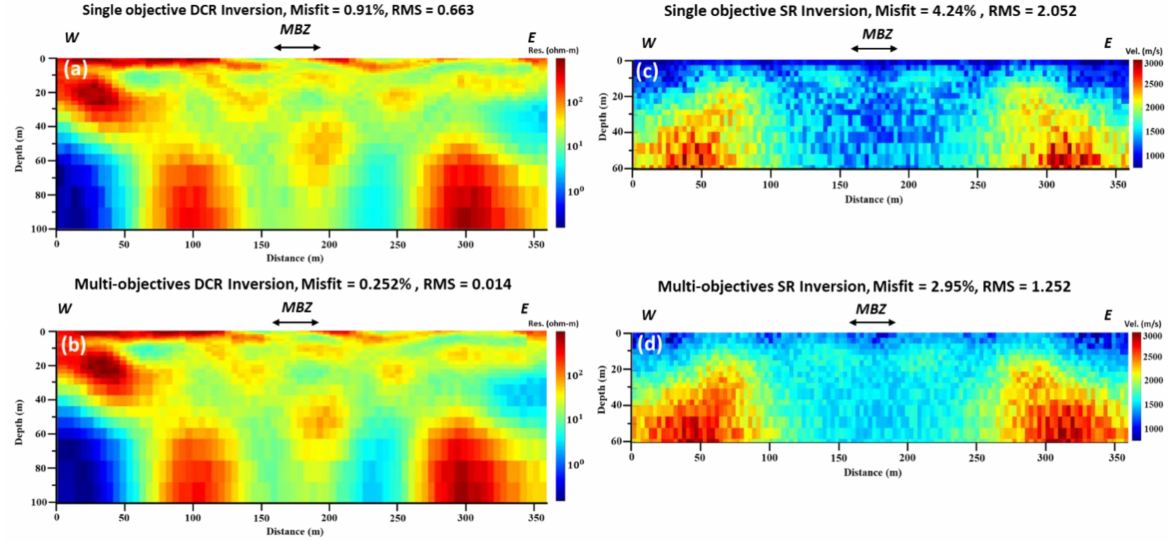
Figure 3. DCR and SR inversion using global optimization method: ( a ) single objective optimization resistivity model; ( b ) multi-objectives optimization resistivity model; ( c ) single objective optimization velocity model; and ( d ) multi-objective optimization velocity model. All geophysical models are vertically exaggerated by